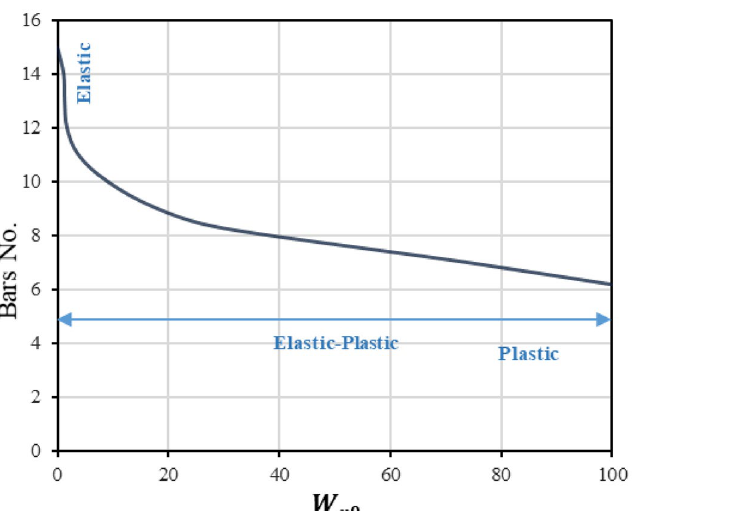
Figure 16. Bars No.-complementary strain energy